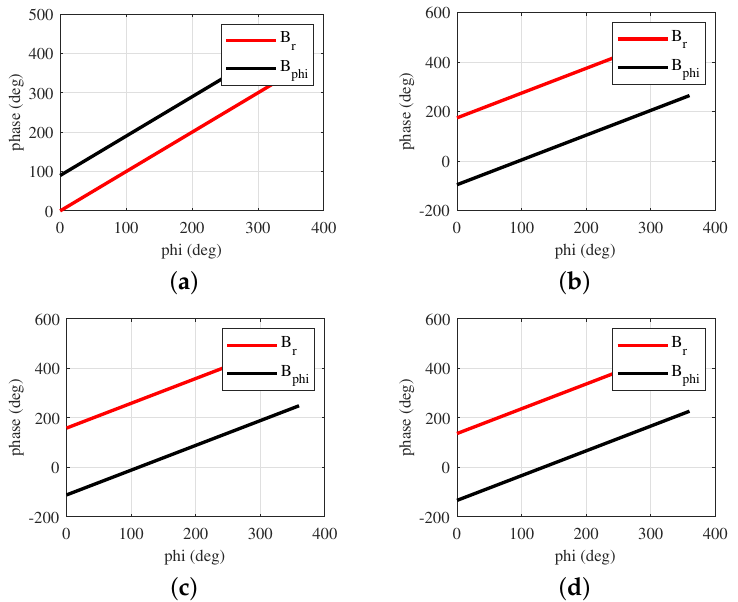
Figure 6. Change in B r and B ϕ with azimuth at different depths: ( a ) depth = 0 m; ( b ) depth = 150 m; ( c ) depth = 300 m; ( d ) depth = 450